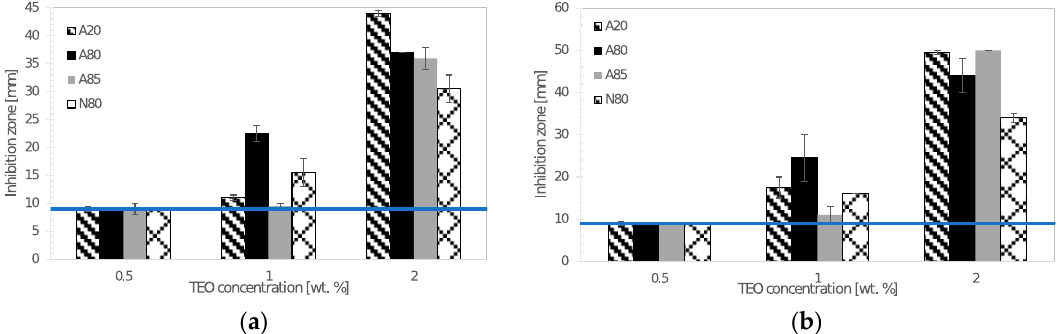
Figure 7. Inhibition zones of chitosan films against ( a ) Candida albicans , and ( b ) Aspergillus niger . The straight line indicates the control chitosan sample.